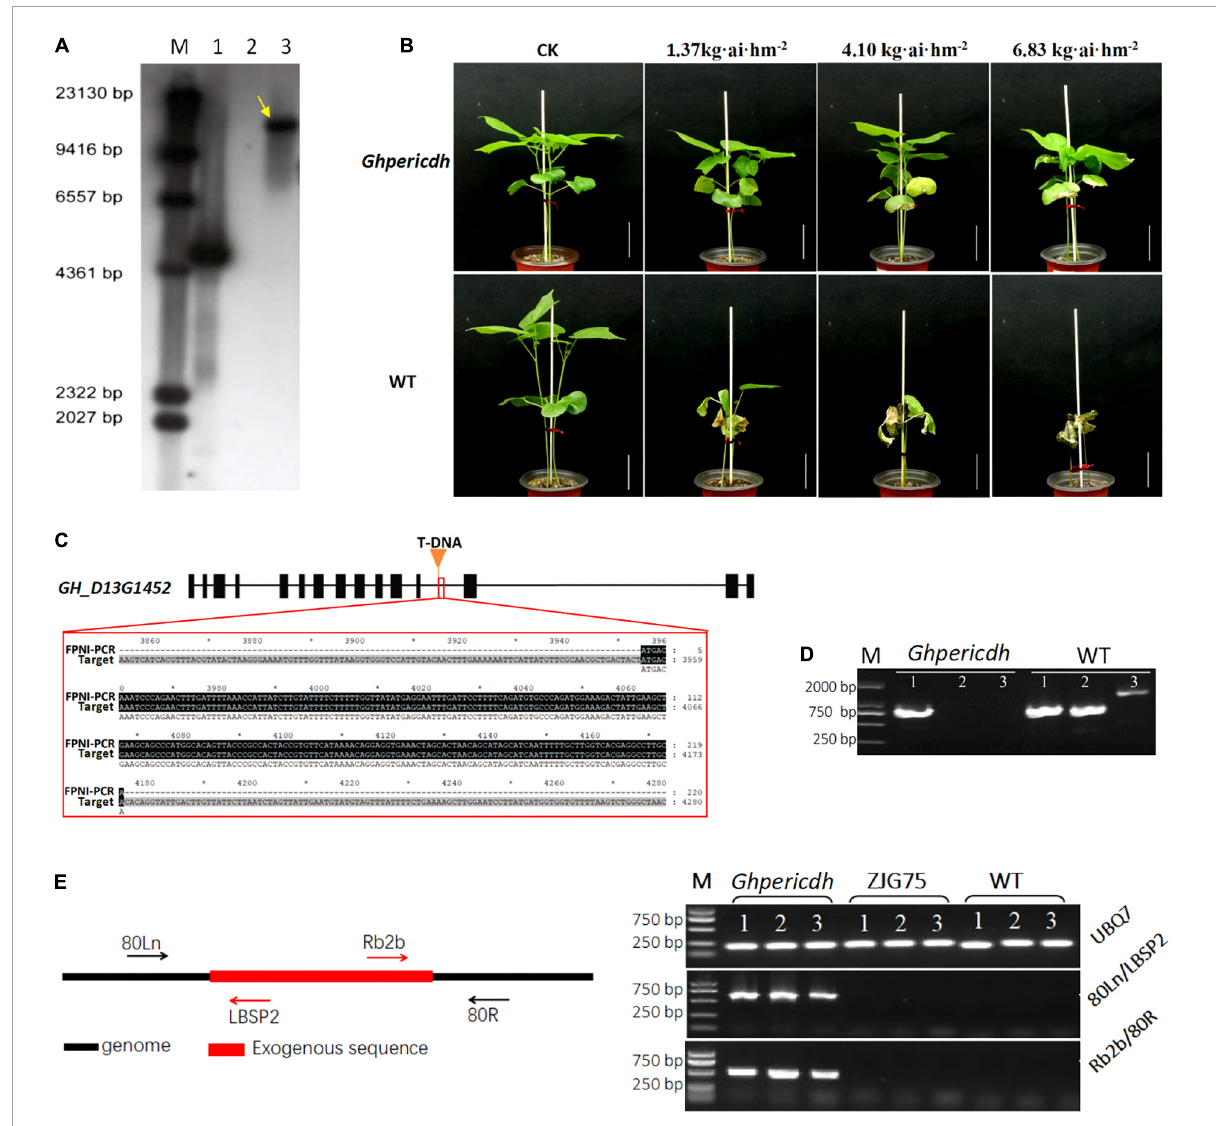
FIGURE2 Identification of mutant Ghpericdh . (A) Southern blotting with a g10evo probe. The yellow arrow displayed one copy of the glyphosate resistance gene in the Ghpericdh . M, marker; 1, positive plasmid; 2, Wild-type plants; 3, Ghpericdh plants. (B) Glyphosate resistance of Ghpericdh . Scale bar = 5 cm. (C) The insertion position of g10evo in GH_D13G1452 . The orange triangle represents the inserted position. The red box showed the flanking sequence (the black region) from FPNI-PCR. (D) RT-PCR analysis of GH_D13G1452 . M, marker; 1, the partial cDNA fragment of homologous gene GH_A13G1507 ; 2, the partial cDNA fragment of GH_D13G1452 ; 3, complete cDNA of GH_D13G1452. (E) Specific molecular markers for mutant Ghpericdh . The left is the positions of two groups of primers 80Ln/LBSP2 and Rb2b/80R. The